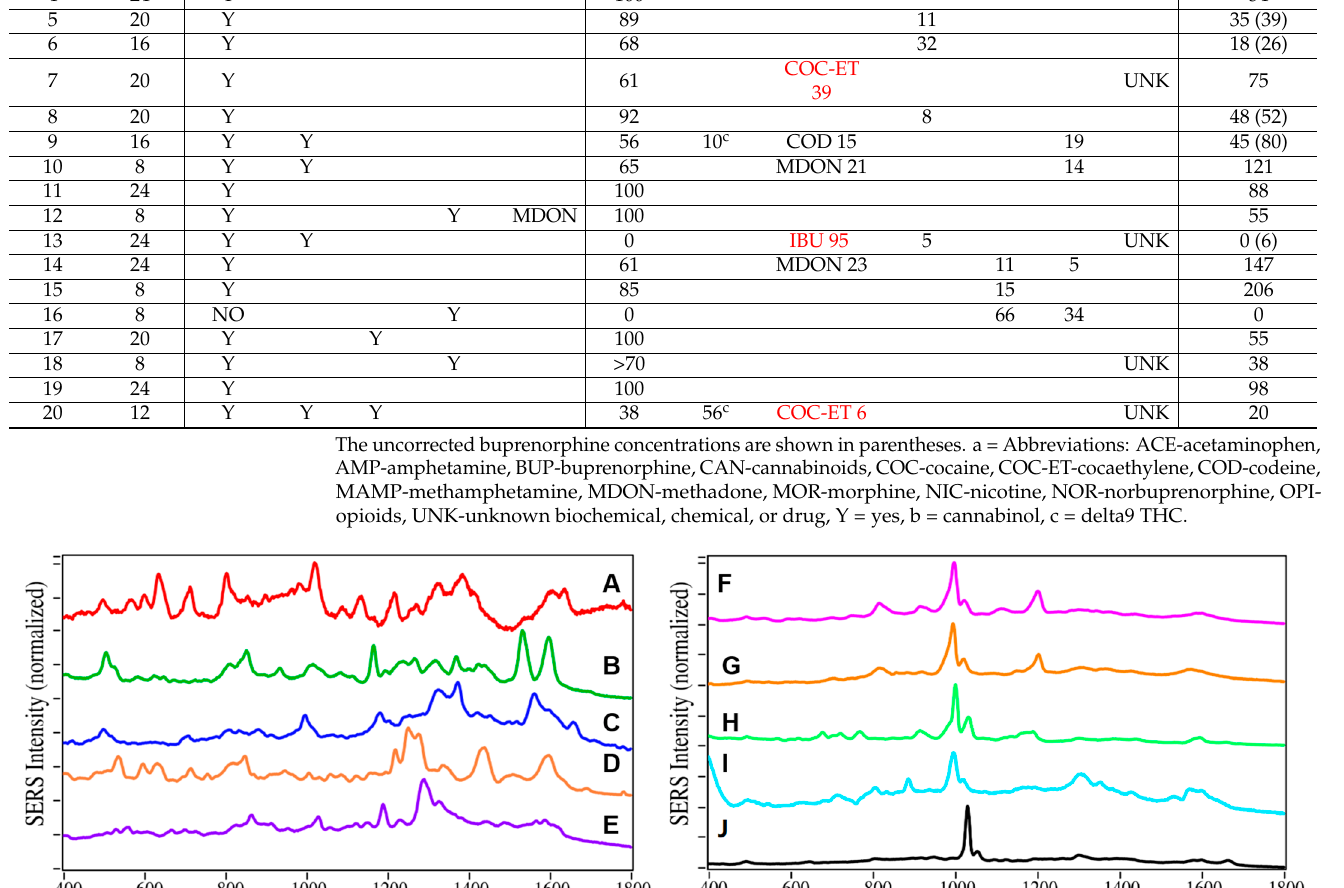
6 of 15 Table 1. Sample number, daily dose, urinalysis, SERS analysis (drugs identification and percent-